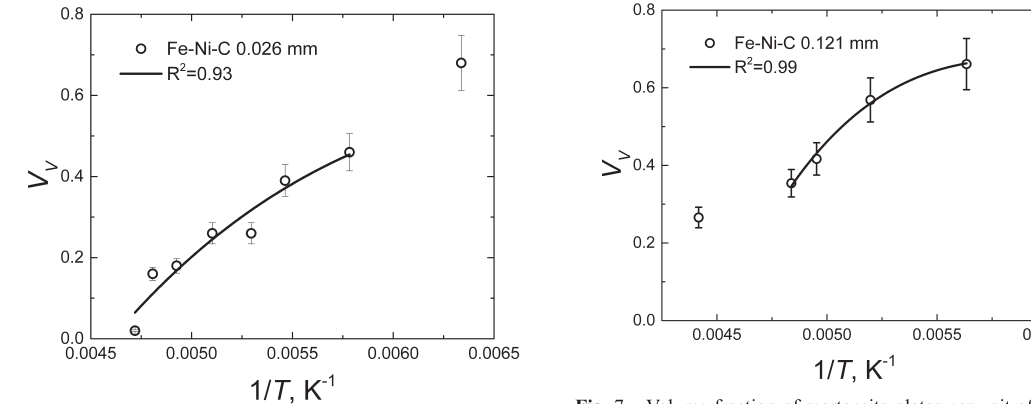
Fig. 5 – Volume fraction of martensite plates per unit of volume against transformation temperature. Fe-31wt%Ni-0.02wt%C alloy 30 with a mean intercept length of austenite grains equal to 0.026 mm. Solid line corresponds to the model developed here: equation 9. Error bars corresponding to an estimated relative error of ±10% were added to the plot. Outlier was excluded from the fitting.